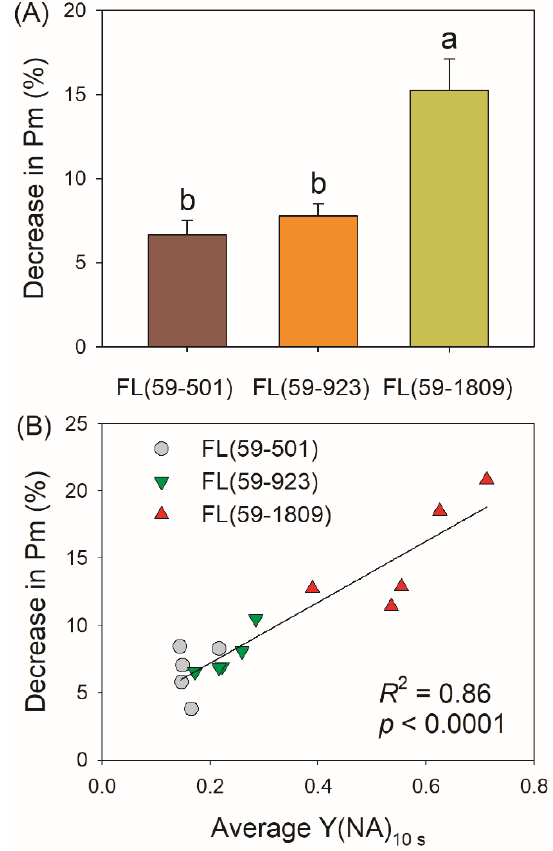
Figure 4. Photoinhibition under different fluctuating light conditions. ( A ) The decrease in the maximum photo-oxidizable P700 ( P m ). Data are shown as means ± SE ( n = 5). Significant differences among different FL treatments are examined by Tukey–Kramer multiple comparison tests ( p < 0.05). ( B ) The relationship between the decrease in P m and Y(NA) 10 s . Y(NA) 10 s indicates the average value of Y(NA) within the first 10 s after switching to high light. Each plot represents the data of an individual leaf. Different letters (a and b) indicate significant differences between different treatments.